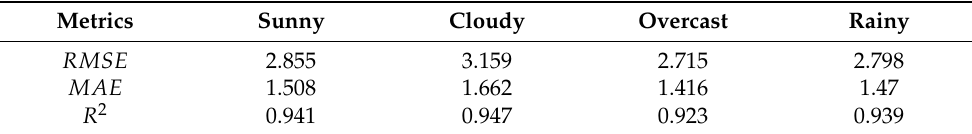
Figure 8. The summary of the temperature and weather conditions. Table 6. The GCN model performance under different weather